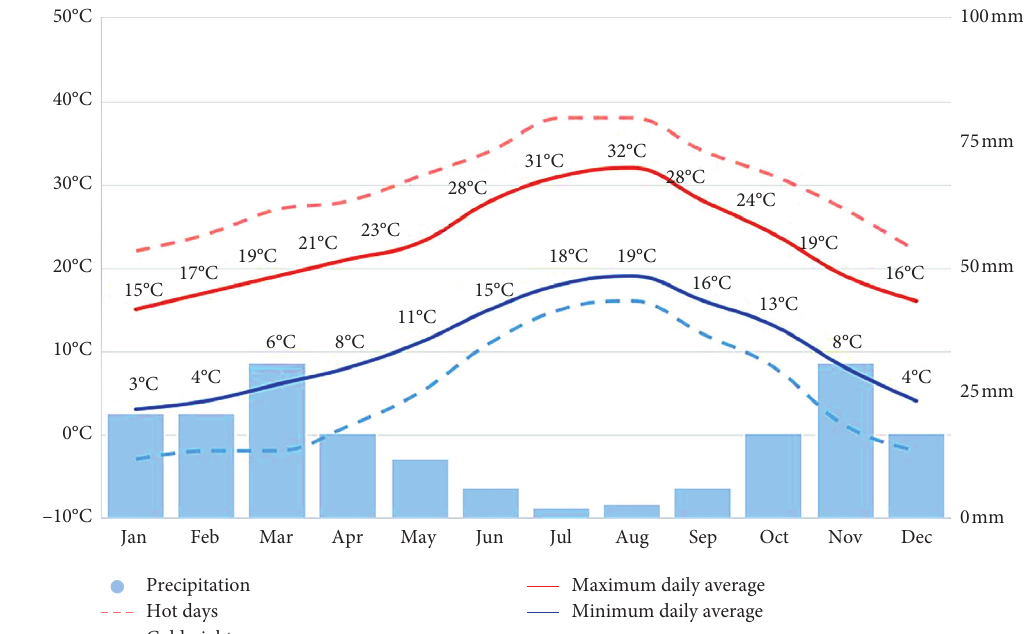
Figure 2: Climodiagram of the study area, Zegzel watercourse,